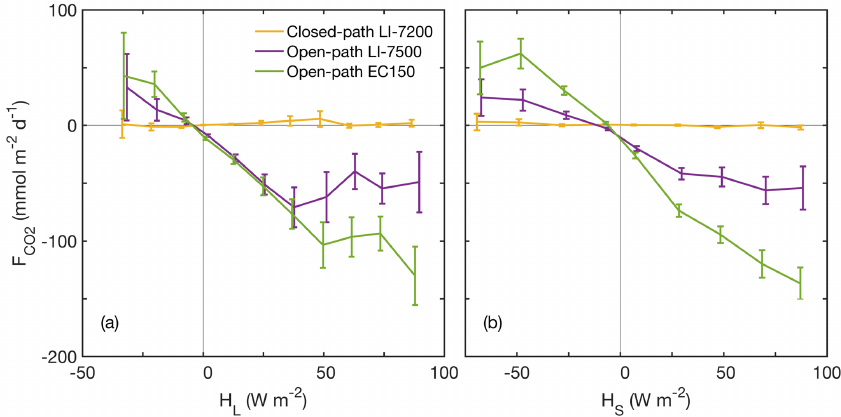
Figure 11. Bin averages of the relationships between F CO calculated from all three IRGAs and (a) H L (LI-7500) and (b) H S . 2 where k is the gas transfer velocity, s is the solubility of CO 2 (RV) Martin Bergmann , which made several courses past the in seawater, and p CO 2w and p CO 2atm are the partial pres- island in August 2017. For the flux intervals that aligned tem- sure of CO 2 in water and the atmosphere, respectively (Wan- porally with these passes (all fully open water), we calculated k 660 ( k adjusted to a Schmidt number ( Sc ) of 660). The k 660 ninkhof and McGillis, 1999). While F CO and p CO 2atm were 2 continuously measured by the EC system, s and p CO 2w were values plotted against U 10 (Fig. 12) showed good agreement n not. They were however, measured aboard the research vessel with previous parameterizations of k 660 (Wanninkhof,